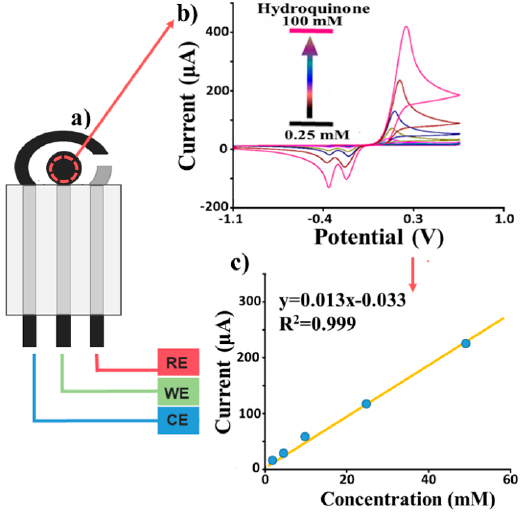
Figure 1. ( a ) A conceptual scheme of a screen-printed electrode; ( b ) example of current-potential curves as the output of a cyclic voltammetry for different values of the analyte concentration (here hydroquinone); ( c ) extrapolated calibration curve (blue dots: experimental current peaks).